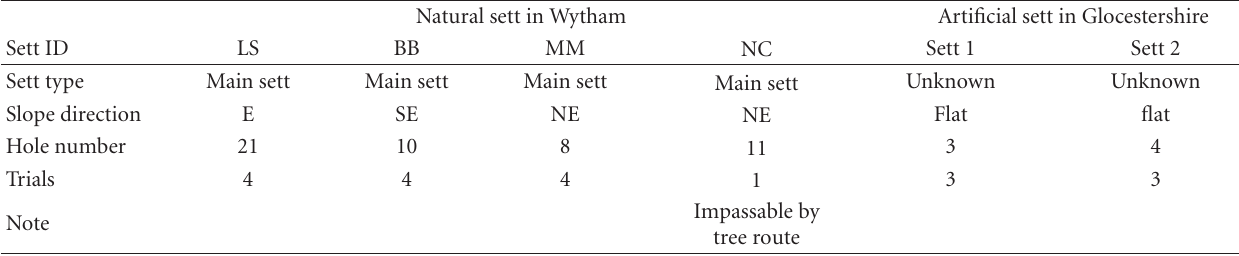
Table 1: Sett types and trials by the sett thermometer probe in 2003.